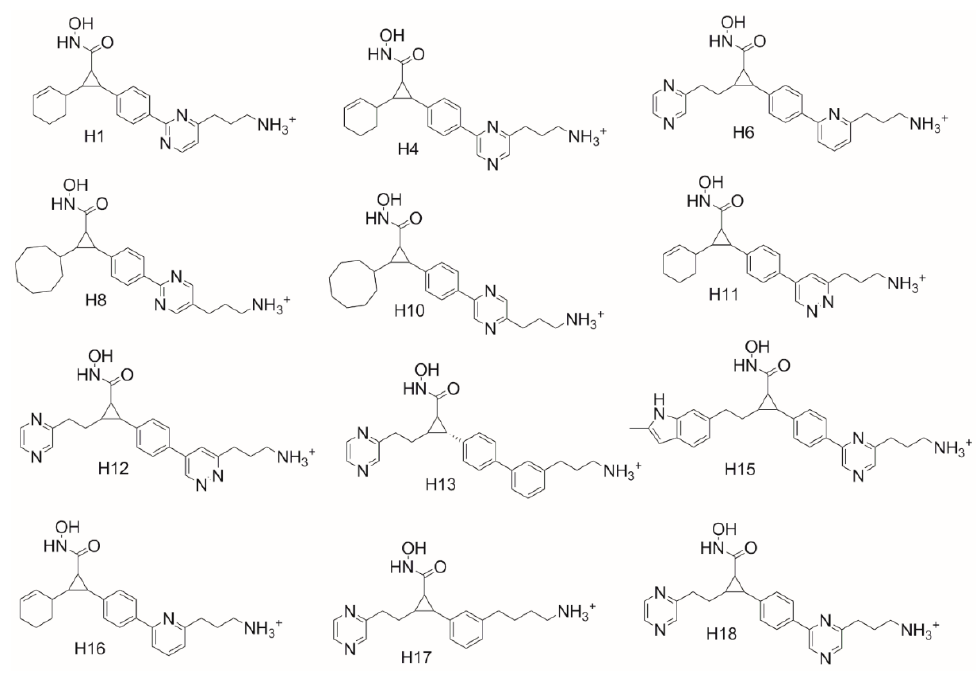
Figure 4. Structure of our designed hybrid compounds having optimized molecular features to interact. Table 6. Docking scores of our designed cyclopropane hybrid derivatives in HDAC4 and HDAC5 receptors.